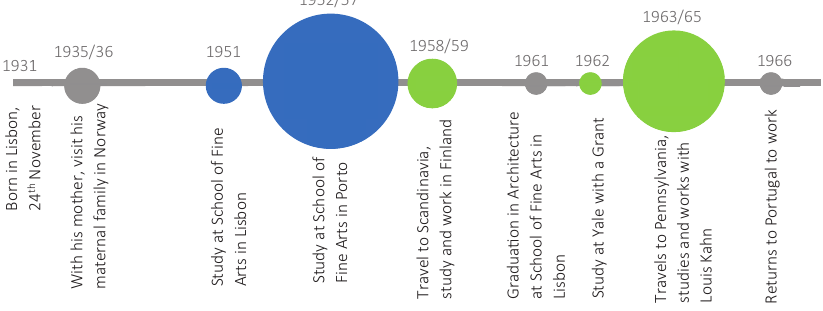
Figure 2. Chronological Hestnes Ferreira’s academic and professional path (source: by the